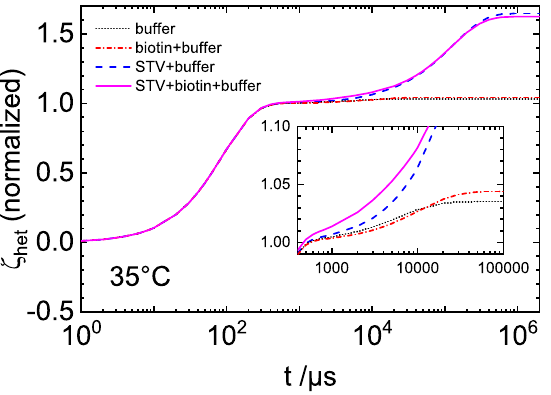
Figure 2. Normalized heterodyne diffraction intensities as function of time for various solutions: buffer (black dotted line), B + buffer (red dash-dotted line), STV + buffer (blue dashed line) and STV + B-buffer (magenta solid line).